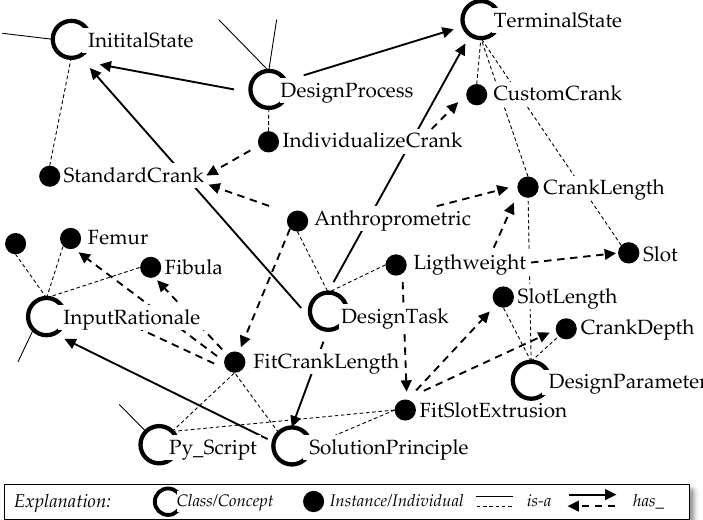
Figure 12. Excerpt from the visualization of the ontological knowledge